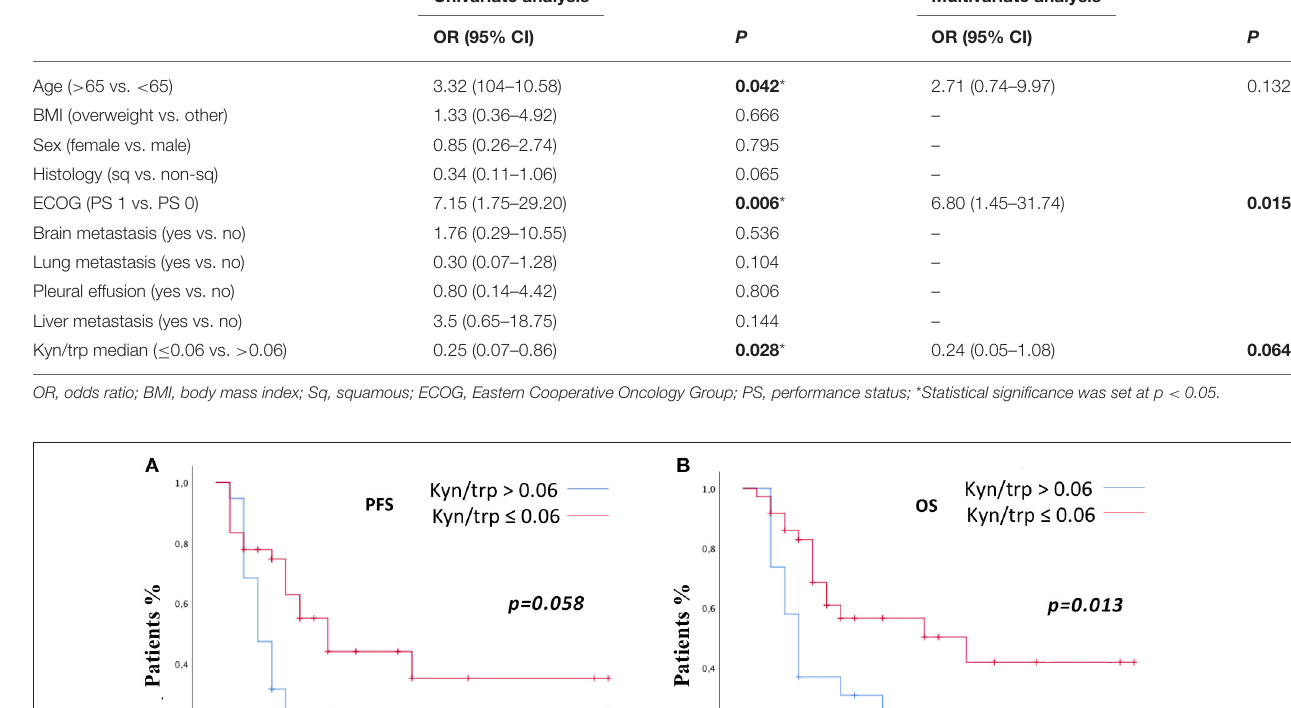
TABLE 3 | Univariate and multivariate analyses: association between patients characteristic and early progression. Univariate analysis Multivariate analysis